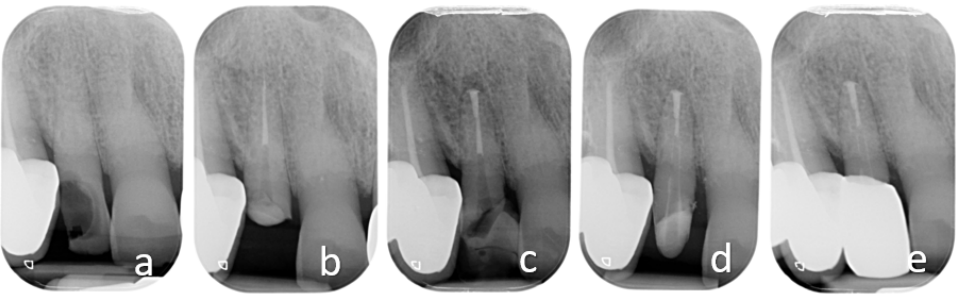
Figure 5. Surgical extrusion of 1.2 tooth with insufficient ferrule effect. Preoperative radiograph ( a ). Primary endodontic treatment ( b ). Reimplantation after retrograde endodontic treatment and splint ( c ). Tooth preparation and prosthetic rehabilitation after healing process ( d , e ).